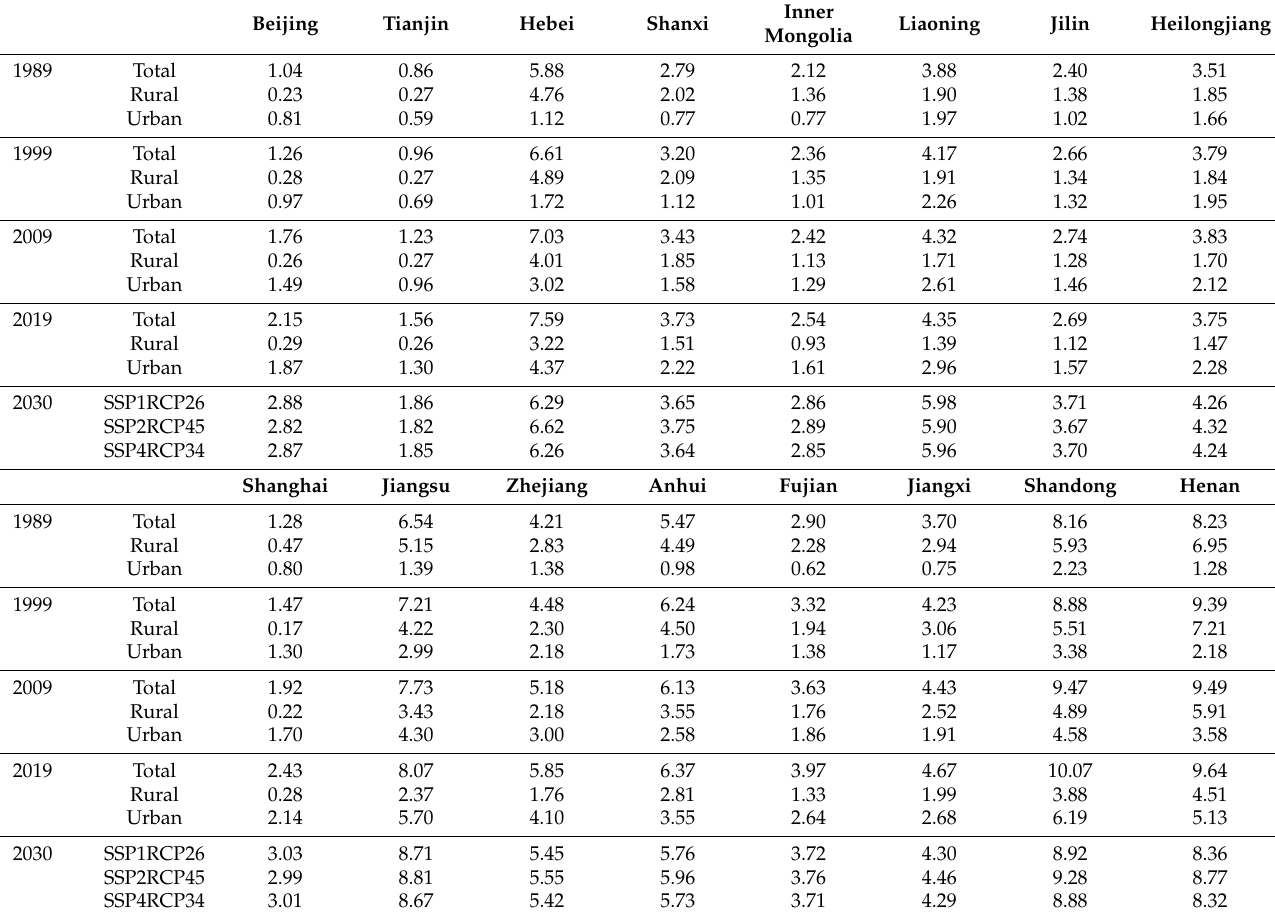
Table 4. Population of each province from 1989 to 2030, unit: 10 7 . Beijing Tianjin Hebei Shanxi